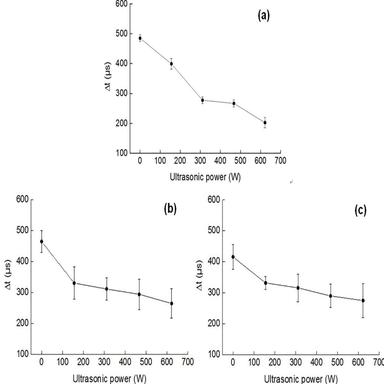
Influence of the ultrasonic power on the time duration used for detecting the first signal below the hole exit during the through-hole drilling process using the (a) third, (b) fourth and (c) fifth laser pulses.